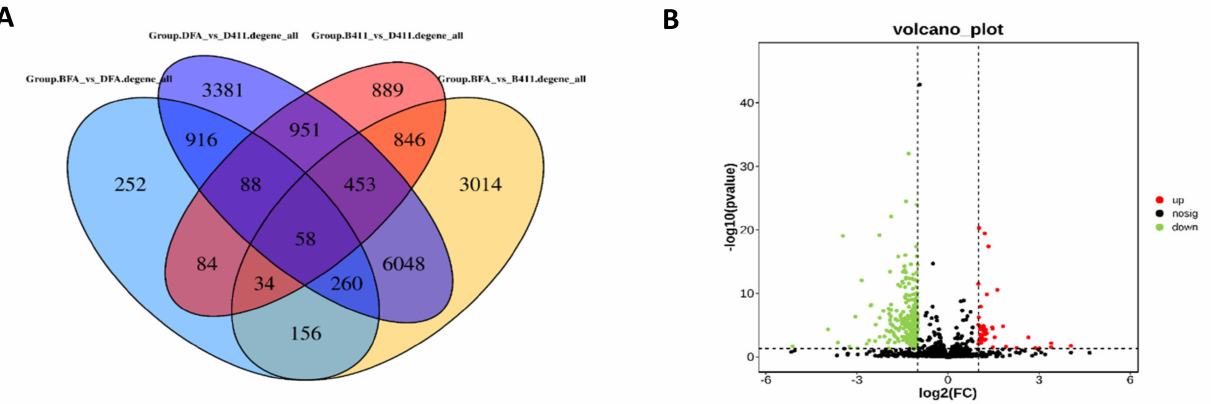
Figure 4. Analysis of DEGs between the samples. ( A ) Venn diagram of all DEGs; ( B ) Differences in the abundance of